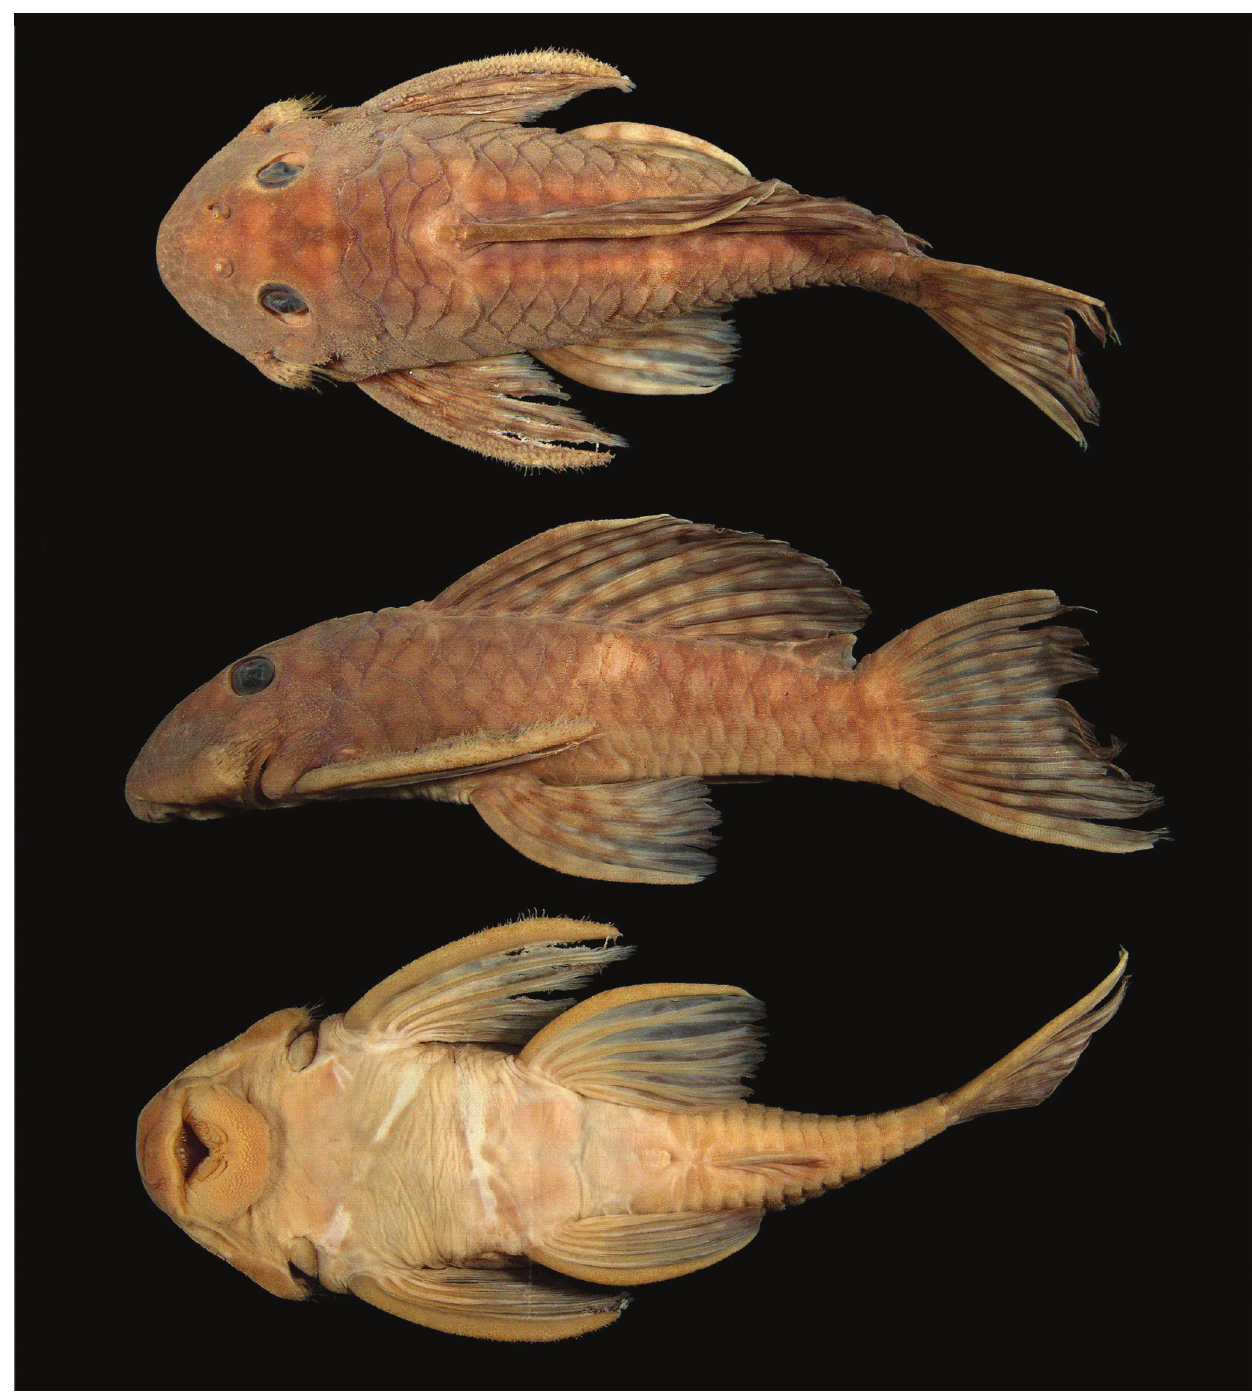
Fig. 14. Spectracanthicus zuanoni , holotype, INPA 25874, 122.5 mm SL, rio Xingu, Pará State,